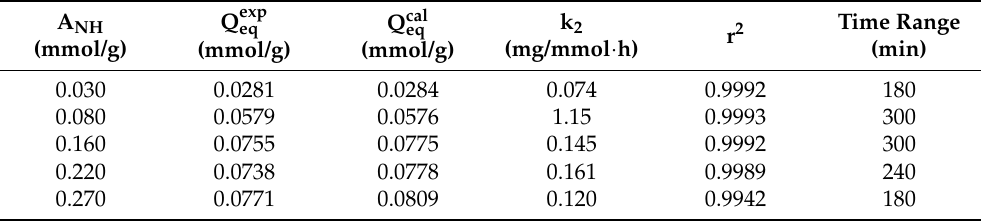
Table 3. The kinetic parameters calculated by the pseudo-second order model for adsorption of Cr(VI) ions on AEAPTES-silica beads with different amino groups in a 0.20 mM K 2 Cr 2 O 7 solution at pH 3.0 and 30 ◦